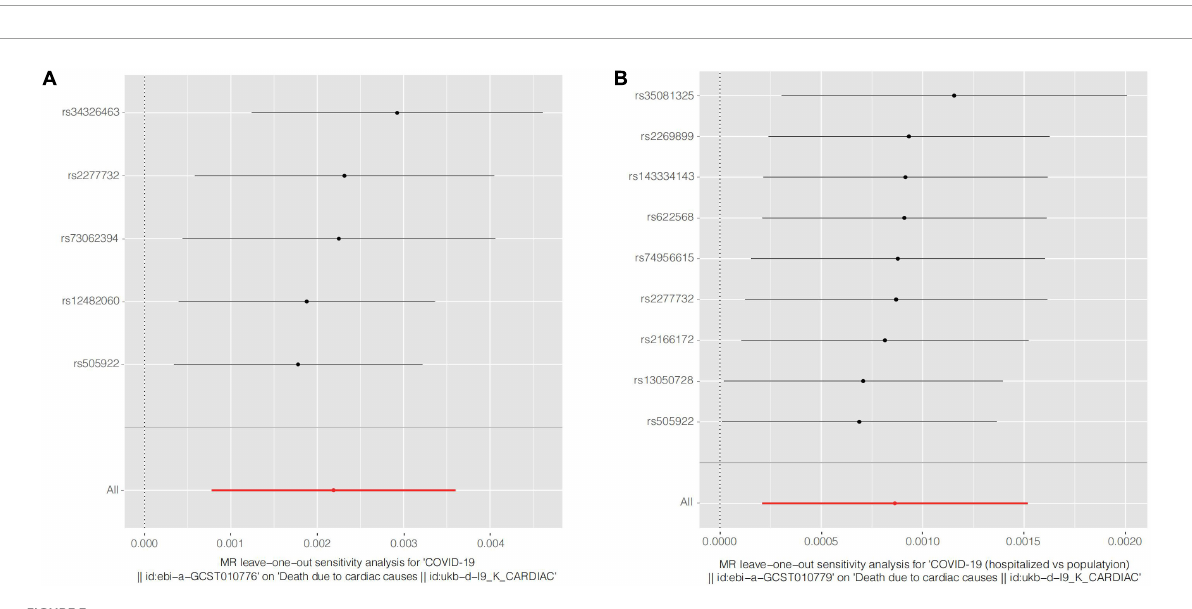
FIGURE3 Forest plots of Leave-one-out analyses for causal SNP effect of COVID-19 on CVD death. The error bars indicate the 95% confidence interval (CI). (A) COVID-19 susceptibility; (B) COVID-19 hospitalization. COVID-19, Coronavirus disease 2019, SNP, single nucleotide